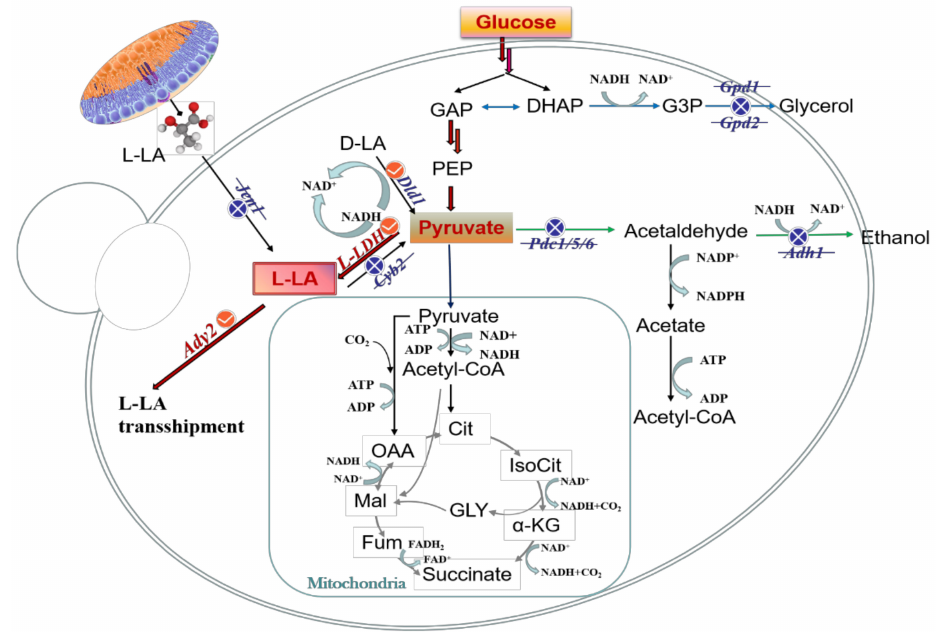
Figure 2. Metabolic regulation strategies map of L-LA. The red line is the L-LA synthesis pathway. The blue line is the by-product glycerol synthesis pathway. The green line is the by-product ethanol synthesis pathway. The blue cross line indicates the blocking pathway. The red checkmark represents the overexpression pathway. GAP, phosphoglyceraldehyde; DHAP, dihydroxyacetone phosphate; Cit, citric acid; IsoCit, isocitrate; α -KG, α -ketoglutaric acid; Fum, fumaric acid; Mal, malic acid. Gpd1/2 , glycerol-3-phosphate dehydrogenase 1/2; L-LDH, L-lactate dehydrogenase (exogenous gene); Cyb2, lactate dehydrogenase (cytochrome); Pdc1/5/6 , indole pyruvate decarboxylase 1/5/6; ACS, acetyl-CoA synthetase; Jen1 , carboxyl transporter Jen1p; Ady2 , accumulation of dyads protein 2, transporter protein required for ammonia export and acetate uptake and